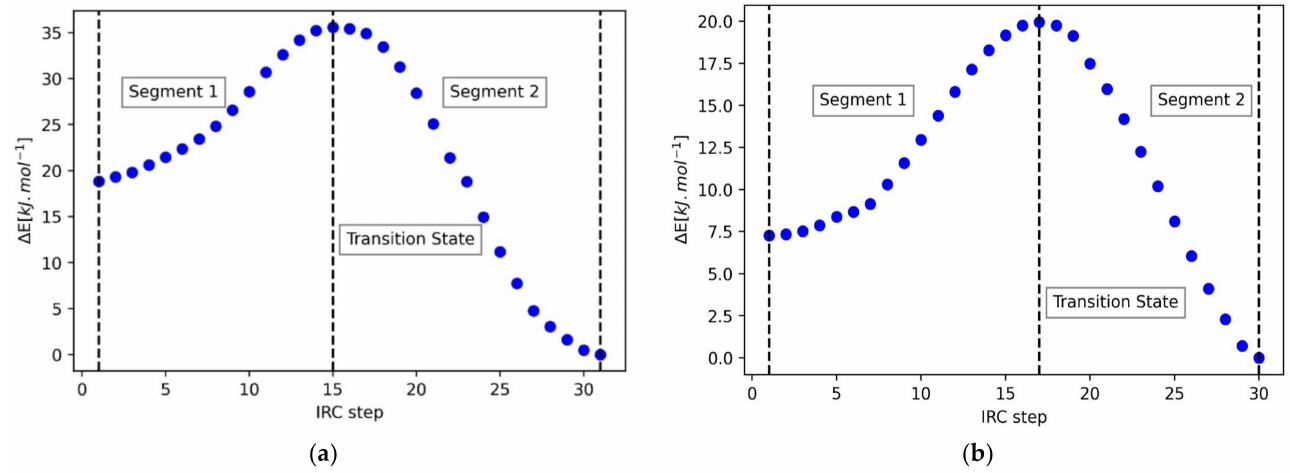
Figure 7. IRC path for ( a ) the R isomer, in the presence of the anomeric effect, and ( b ) the S isomer, in the absence of the anomeric effect. The initial and final geometries correspond to the twist-boat and chair forms, respectively, for both isomers.